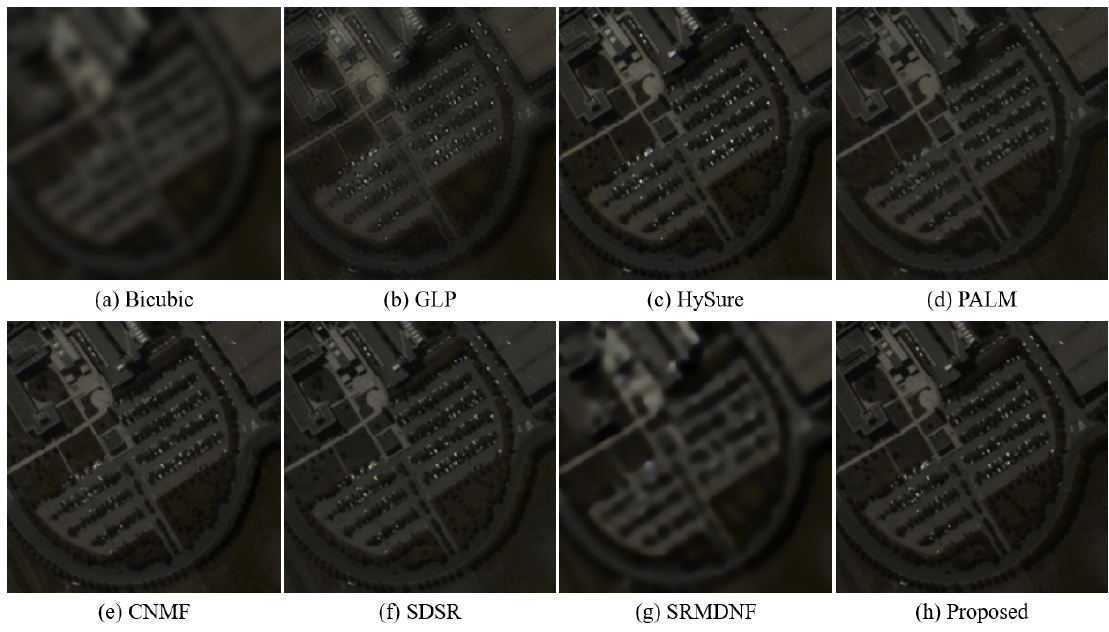
Figure 7. Super-resolution reconstruction results on the Pavia dataset with a magnification factor of three. ( a ) Bicubic; ( b ) GLP; ( c ) HySure; ( d ) PALM; ( e ) CNMF; ( f ) SDSR; ( g ) SRMDNF; ( h ) proposed.